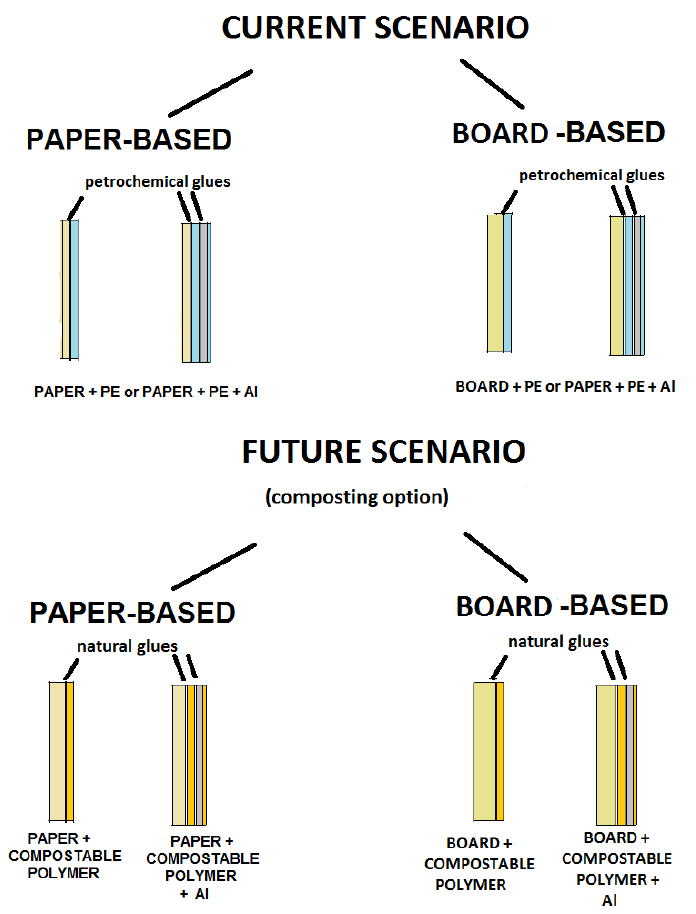
Figure 1. Current and future scenario for multilayer packaging based on cellulose (paper or board) on the literature survey basis.